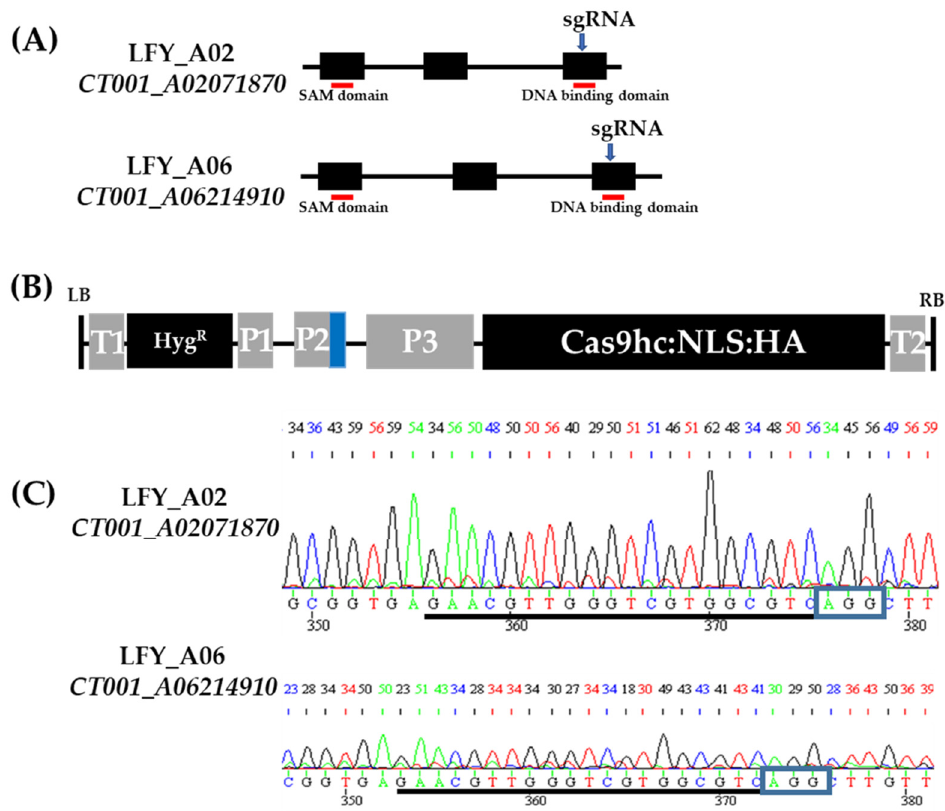
Figure 1. CRISPR/Cas9 gene editing vector construction targeting BrLFY paralogs. ( A ) Gene structure of the BrLFY paralogs. Black box, exon regions; Black line, intron regions; Blue arrow, target region of single guide RNA (sgRNA); and Red line, conserved domain. ( B ) Structure of CRISPR/Cas9 gene editing vector with sgRNA targeting the BrLFY paralogs based on pHAtC. LB, left border; T1, NOS terminator; Hyg R , hygromycin resistance gene; P1, NOS promoter; P2, Arabidopsis U6 promoter; P3, 35S promoter; Cas9hc:NLS:HA, human-codon-optimized Cas9 with the nuclear localization signal and an HA epitope; T2, 35S terminator; RB, right border; and Blue box, sgRNA, and sgRNA scaffold. ( C ) Chromatograms of single guide RNA (sgRNA) sequence in the BrLFY paralogs of inbred line, ‘CT001’. sgRNA sequence is underlined in black and blue rectangles indicating PAM sequence.